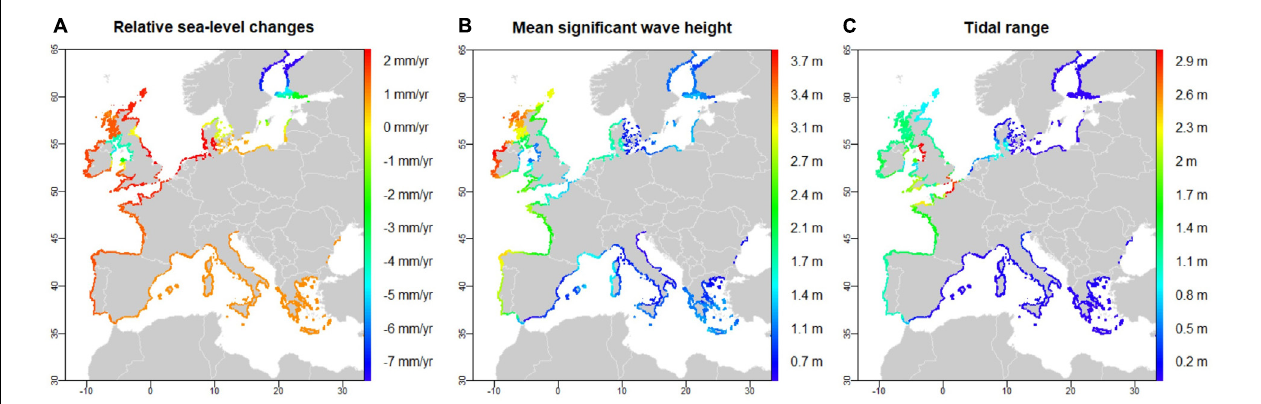
FIGURE 1 | Relative sea level change (A) , mean significant wave height (B) , and tidal range (C) along the European coastlines according to the Eurosion database.